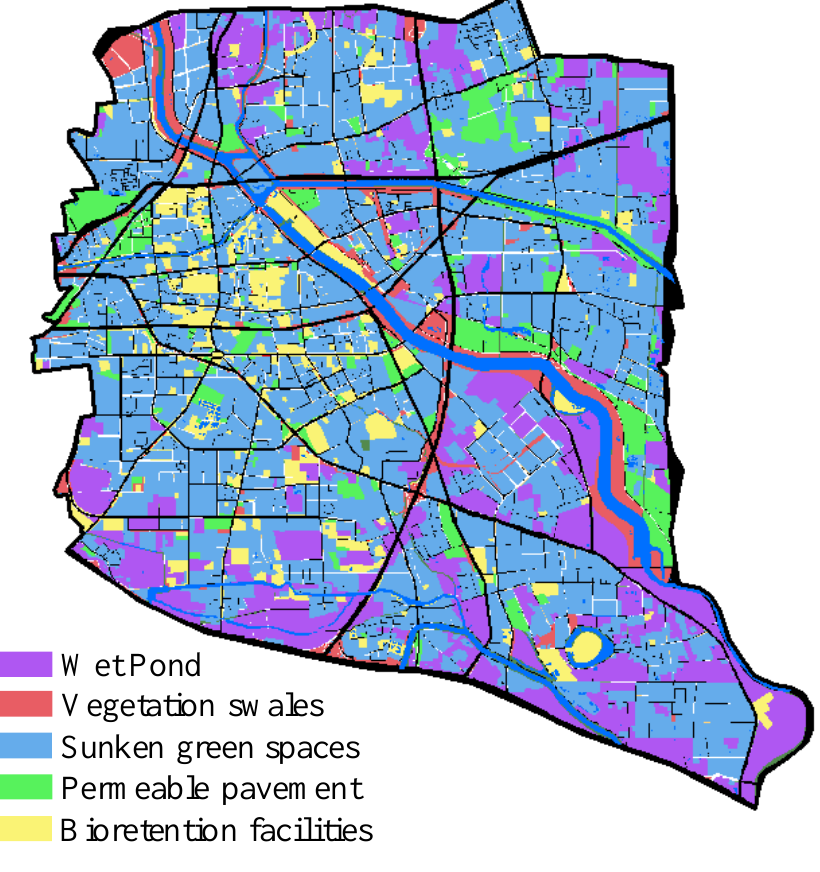
Figure 5. Regional most preferred GI distribution.